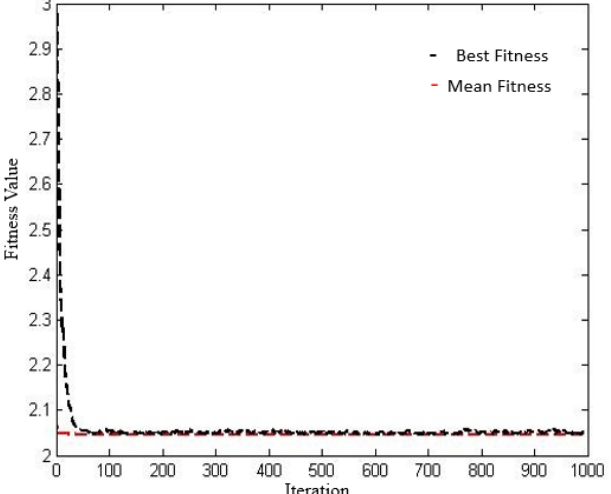
Figure 4. Genetic algorithm analysis and value convergence.